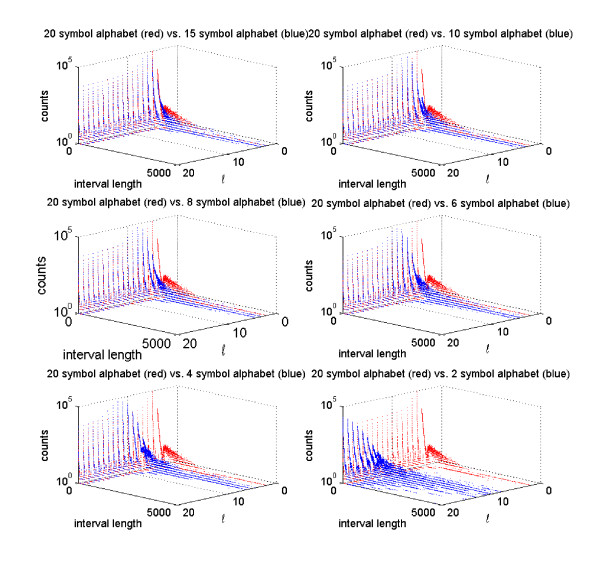
Number of ℓ-intervals for various reduced alphabets. Numbers of ℓ-intervals for ℓ ∈ [1, 20] of different length for various reduced alphabets. We built the enhanced suffix array with sequences from the RCSB protein data bank (PDB) (total sequence length 4,264,239 bytes). The used reduced amino acid alphabets are given in Figure 8. Note that we limited the interval lengths in the figures to 5,000 to prevent distortion.